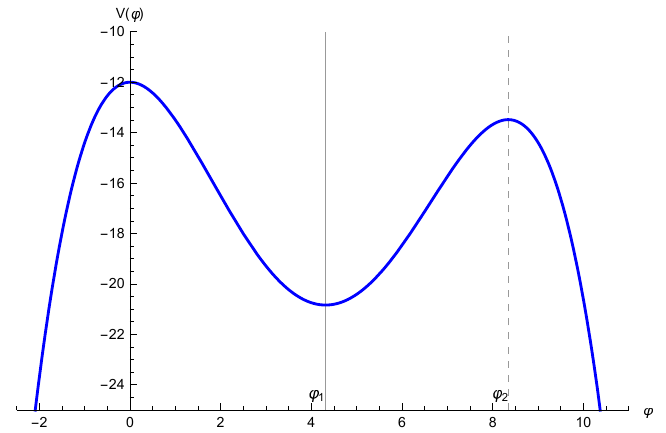
Figure 6 . The scalar potential (2.8) plotted for the specific values, ‘ L = 1 , ‘ R = 0 . 94 , ∆ L = 1 . 6 and ∆ = 1 . 1 . The minimum is located at ϕ R